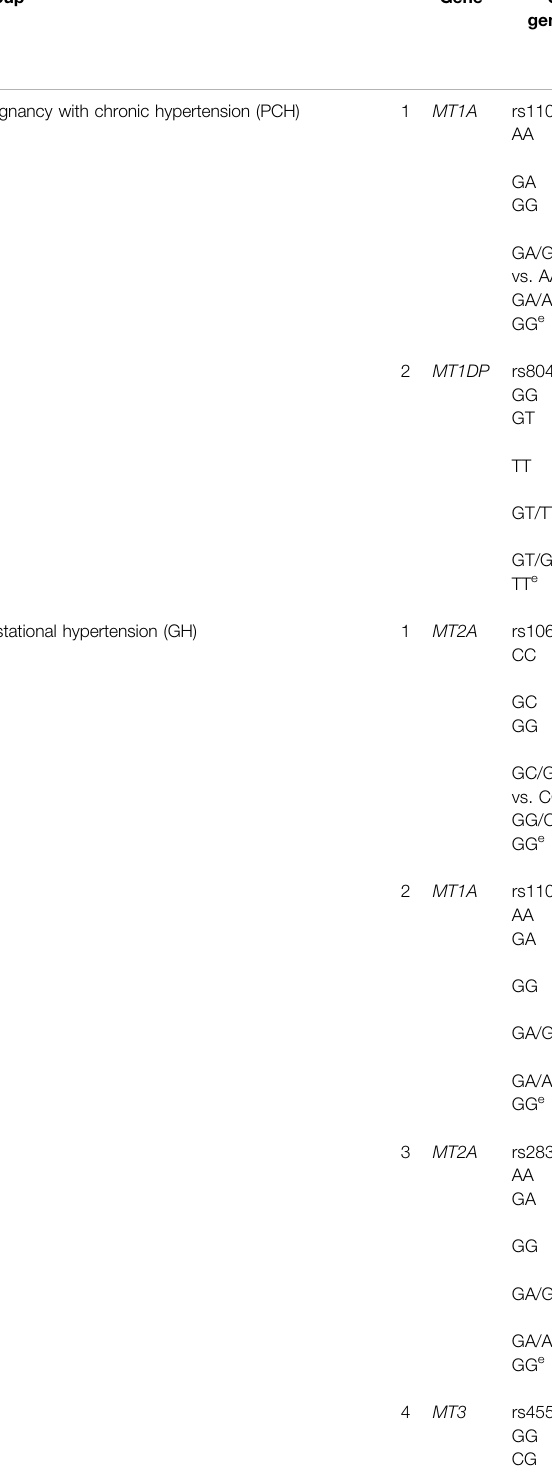
Pregnancy with chronic hypertension